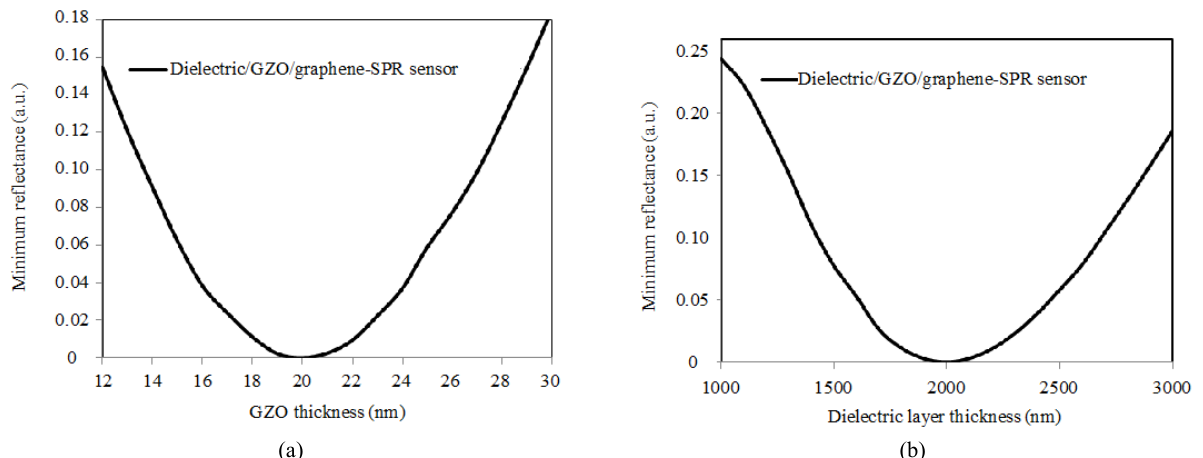
Fig. 2 Plot of the minimum reflectance as function of (a) GZO thickness and (b) dielectric thickness of the proposed GZO/graphene SPR sensor for the optimization of GZO and dielectric thickness [the thickness used for graphene is 0.34 nm, the dielectric thickness varies from 1 000 nm to 3 000 nm, the GZO thickness varies from 12 nm to 30 nm, and RIs for the dielectric medium and sensing medium are n d = 1.34 and n s = 1.33,